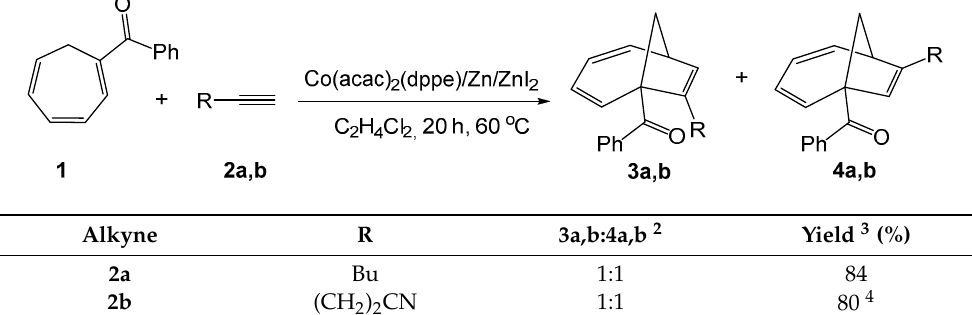
Table 1. Cobalt ‐ catalyzed [6 π + 2 π ] ‐ cycloaddition of 1 ‐ benzoylcycloheptatriene ( 1 ) with alkynes ( 2 ) 1 .